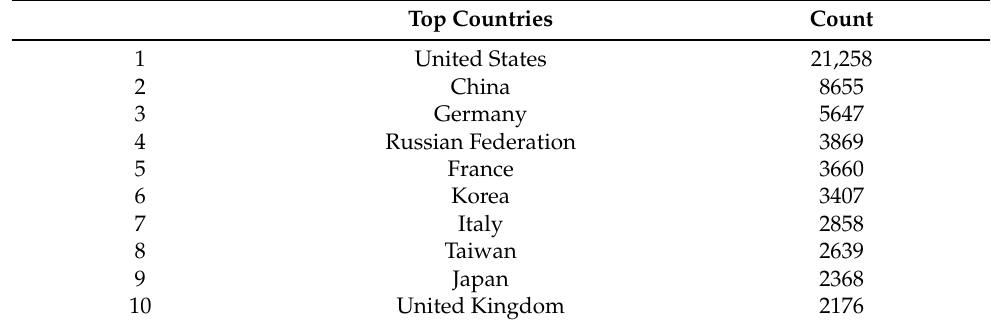
Table 2. Statistics of broken IoT [38].